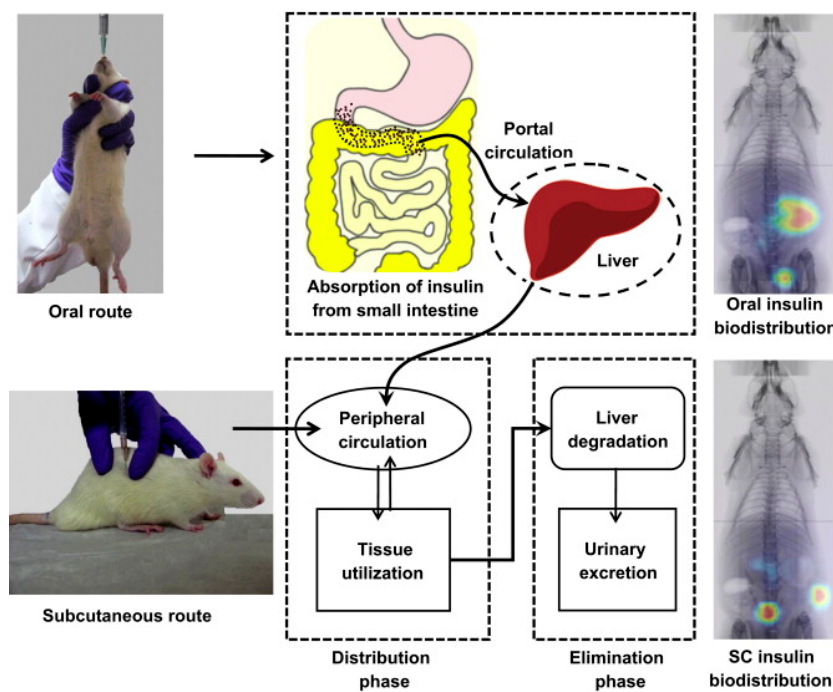
Figure 13. Schematic diagrams illustrating the absorption, distribution and elimination of aspart-insulin following oral or subcutaneous administration to rats. Reproduced with permission from [196]. Copyright 2010, Elsevier Ltd.